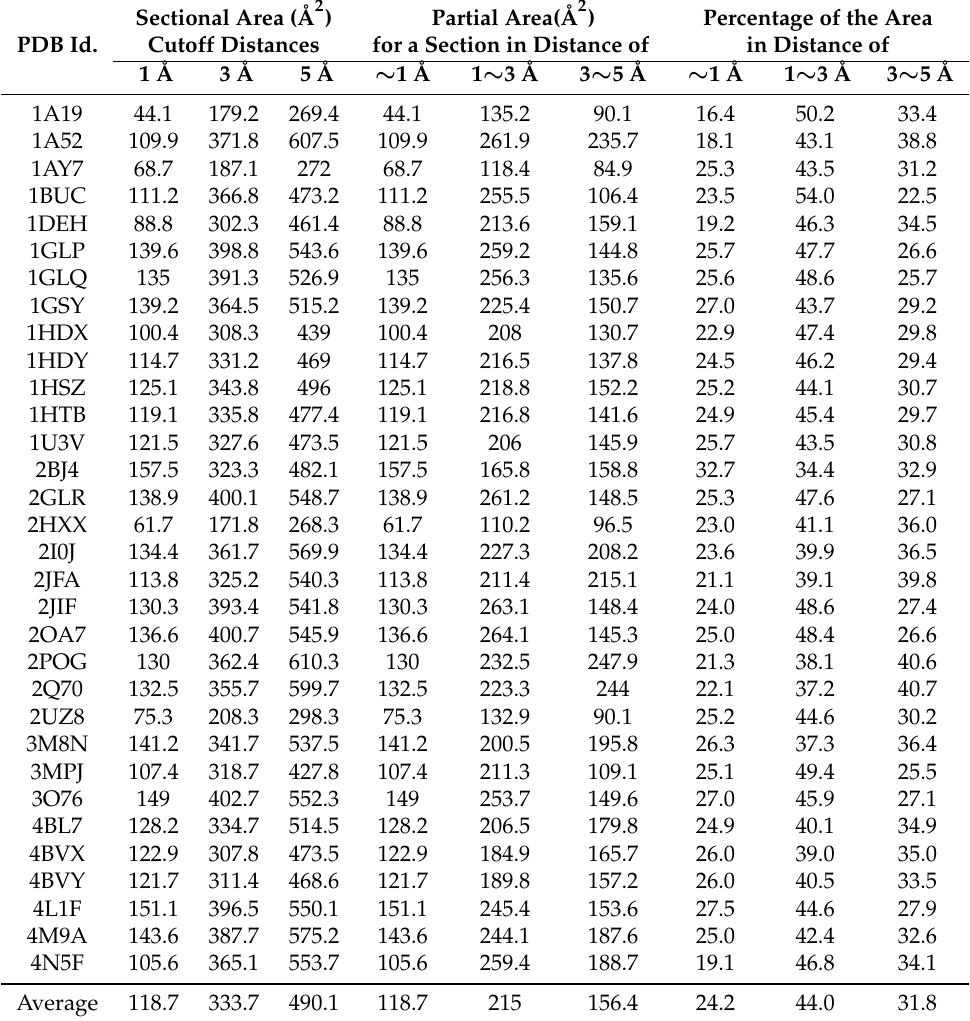
Table 2. The sectional contact area in protein–protein